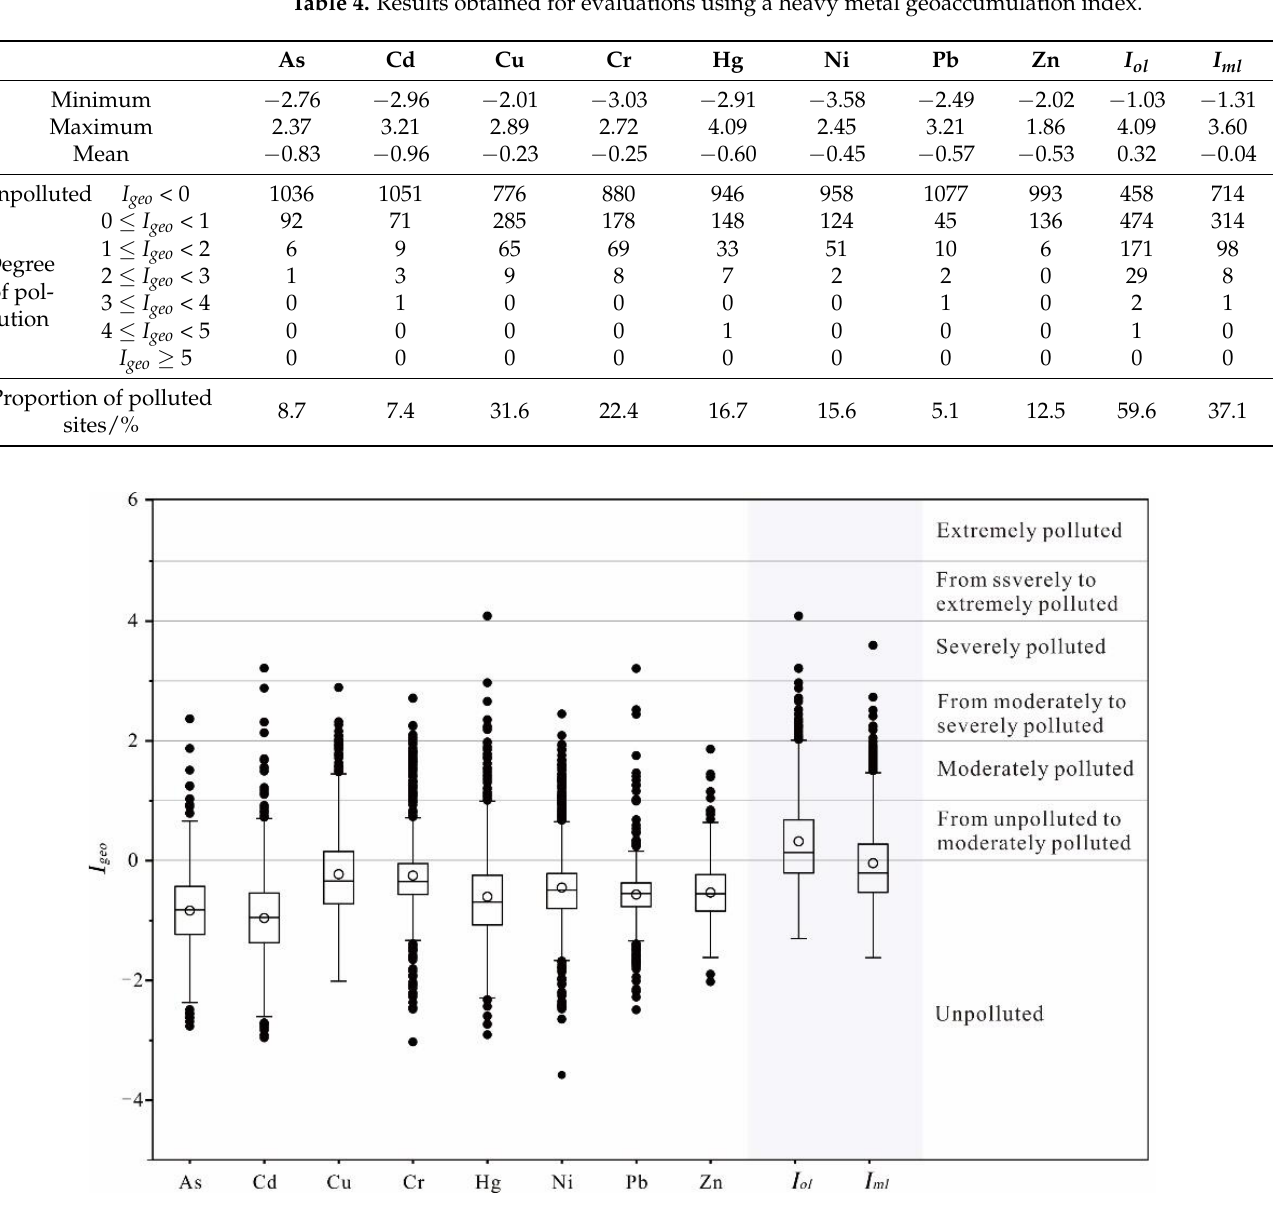
Figure 6. A boxplot of geoaccumulation index ( I geo ) distribution in the study area.